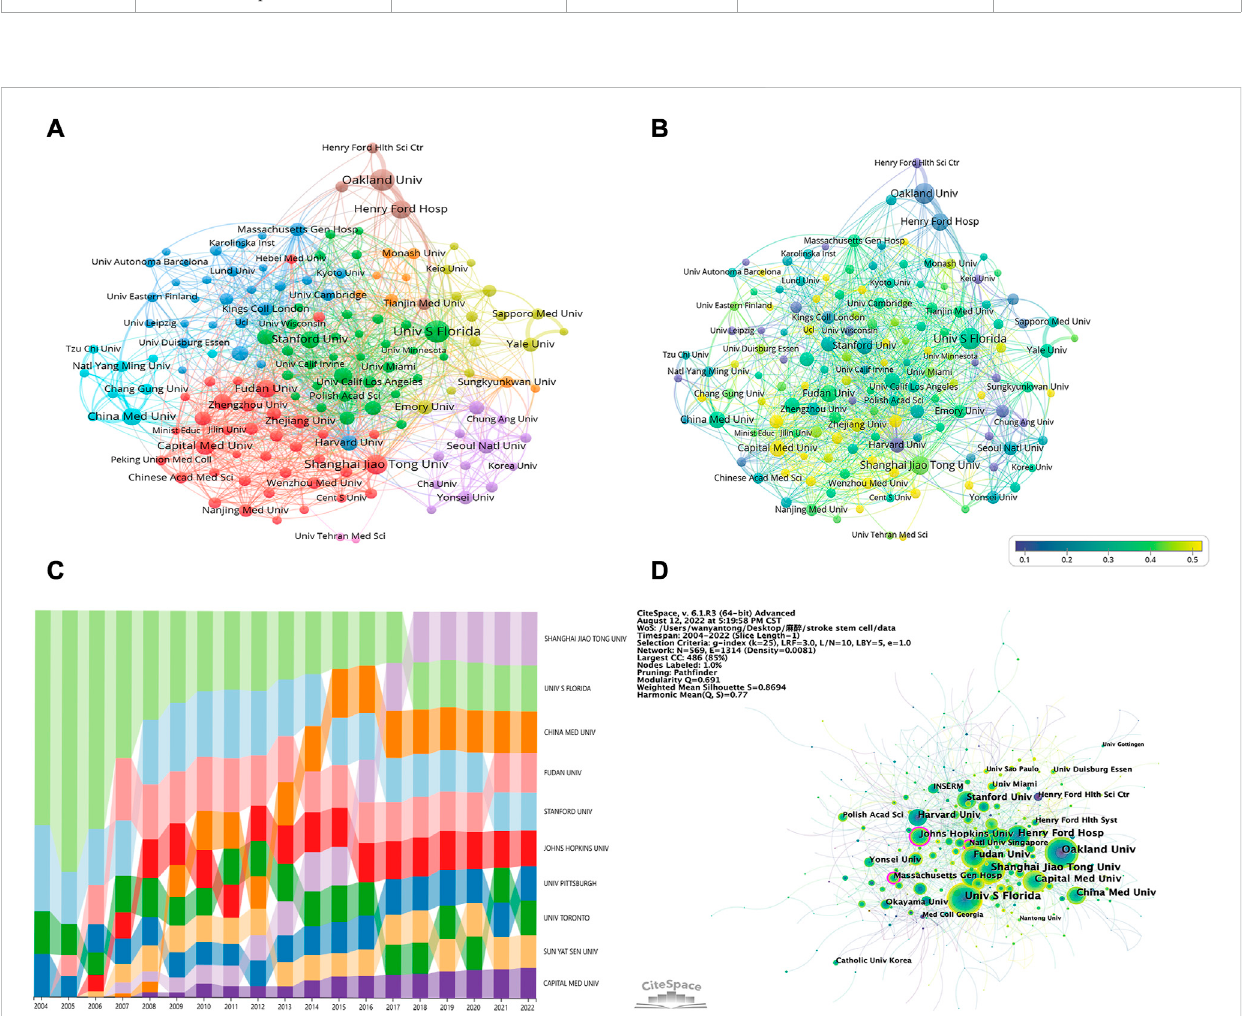
FIGURE 4 (A) Institutions clustering analysis. The node size signi fi es the number of publications of institutions, and the thickness of the line signi fi es the strength of cooperation among institutions; node colors signify different clusters. (B) Timelinevisualization of collaboration among institutions. The blue to yellow gradient represents the number of articles published in the last 5 years as a percentage of the total number of articles published by the organization (C) Trends of publications in this fi eld by different institutions over time. Different colors represent different institutions, the high and low positions represent the ranking of the institution ’ s publication quantity, and the width represents the proportion of the institution ’ s publication quantity among the top 10 institutions ’ publications of the year (D) Institutions related to stem cells in stroke. The larger the circle, the more articles the institution posts. The purple circle represents centrality, and the line means cooperation among